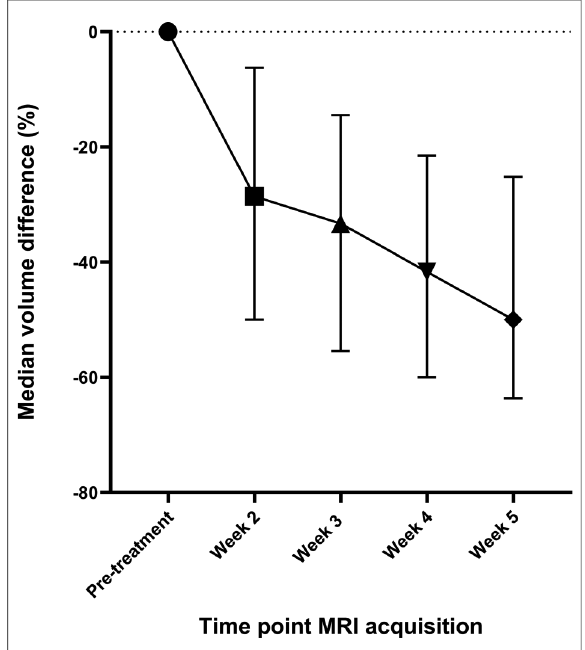
FIGURE 3 The median differences in the volume of elective lymph nodes during the course of radiotherapy compared to the volume of elective lymph nodes in the pre-treatment scan. The whiskers indicate the interquartile